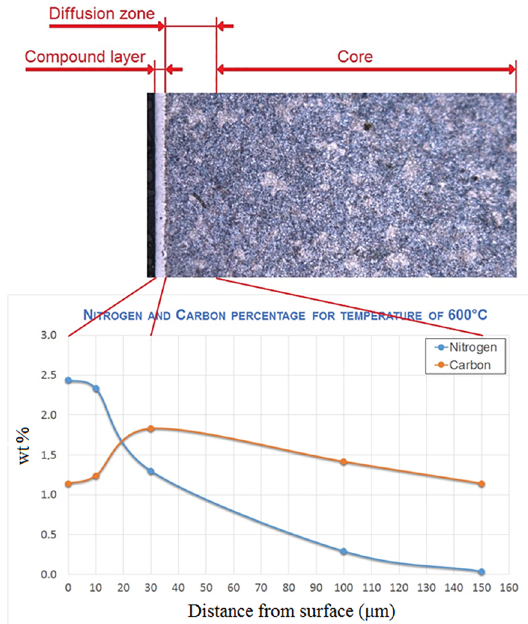
Figure 4. Chemical composition profiles for the samples nitrocarburized at